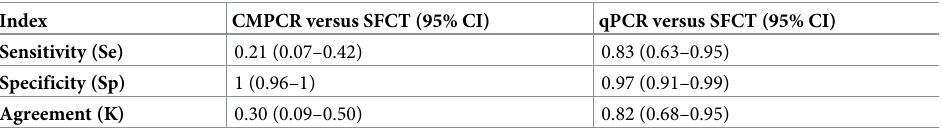
Table 2. Sensitivity, specificity and agreement (K) for two diagnostic methods (CMPCR and qPCR) for